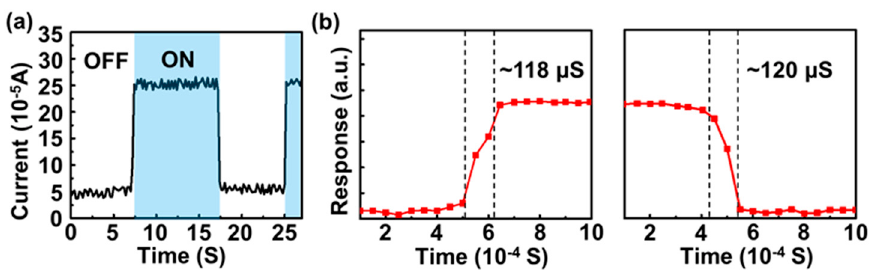
Figure 7. ( a ) The photocurrent and dark current as a function of time of the prepared bilayer graphene/p-Si Schottky PD under a 3 V bias. ( b ) High-resolution time response of the prepared bilayer graphene/p-Si Schottky PD.